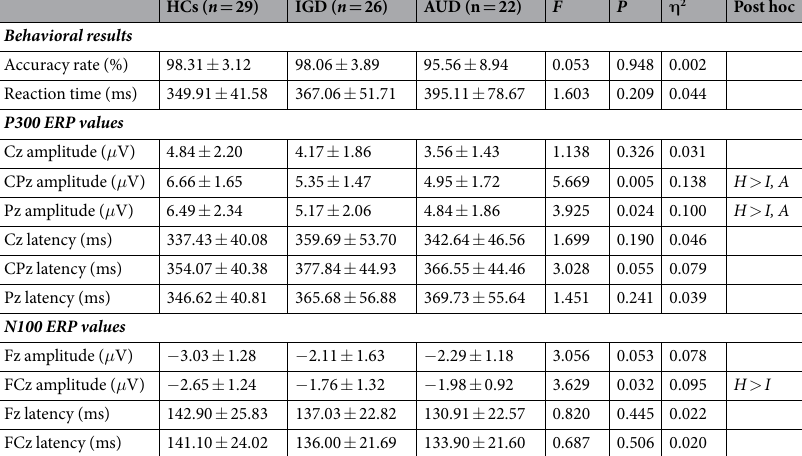
Table 2. Behavioral performance and event-related potential (ERP) values (N100 and P300 amplitudes and latencies) in patients with Internet gaming disorder (IGD) or alcohol use disorder (AUD) and healthy controls (HCs). Data are mean ± standard deviation. * P < 0.05; n.s. = not